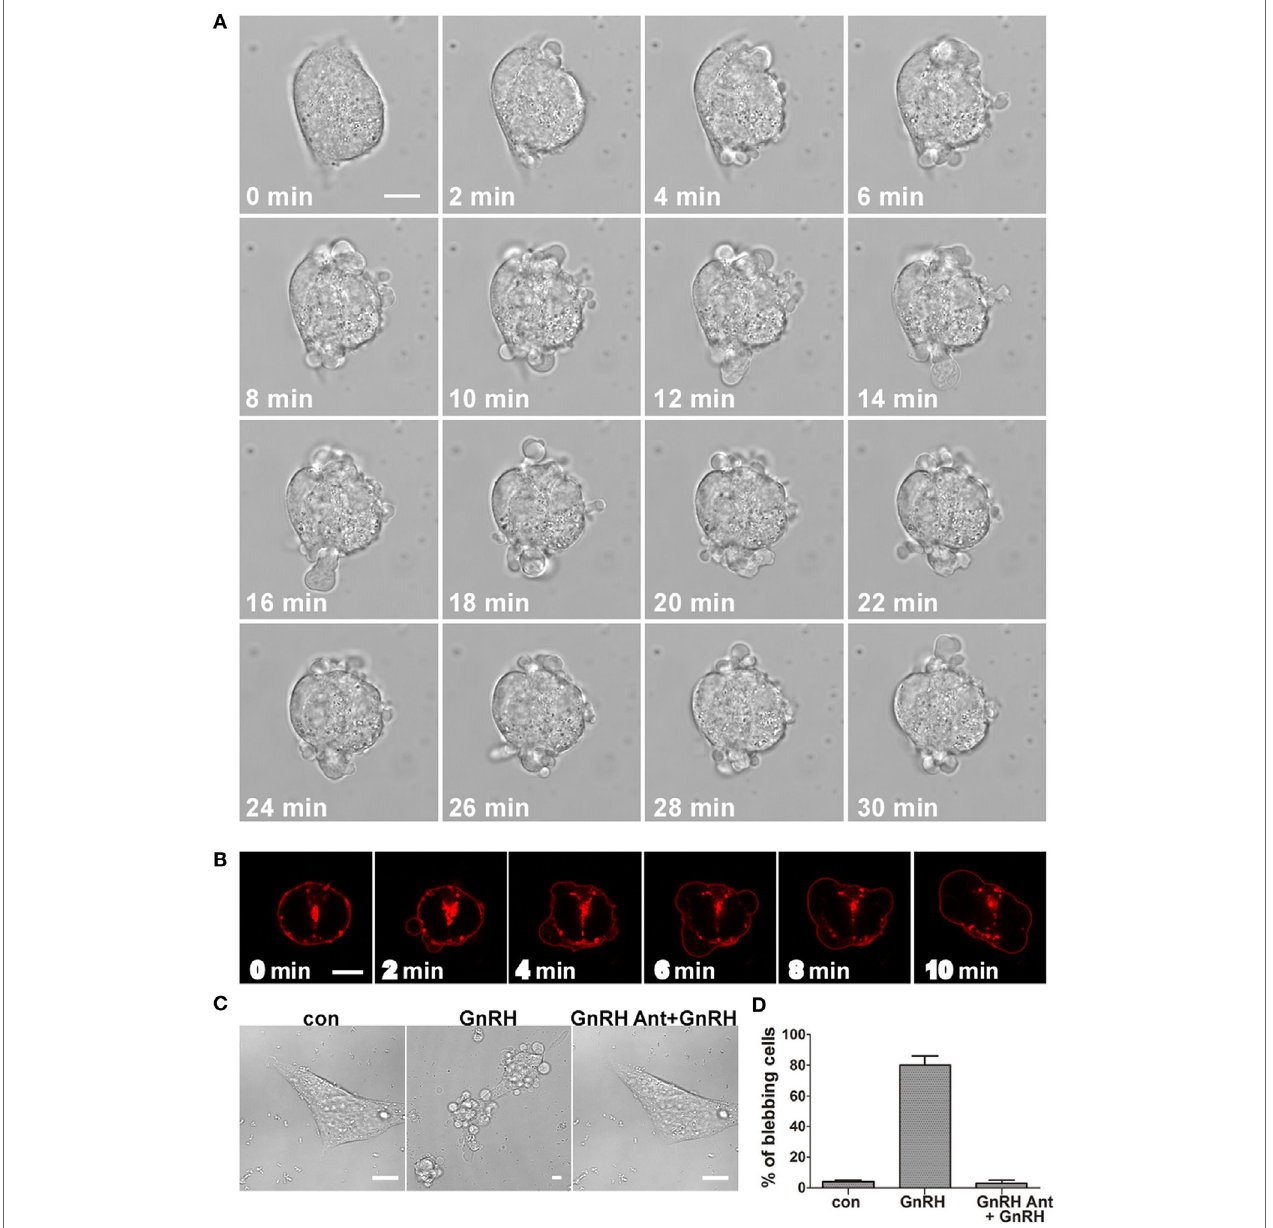
FigUre 1 | gnrh induces bleb formation in l β T2 cells and gnrh receptor (gnrhr) is present in the blebs . (a) Images from a confocal microscopy time-lapse movie of serum-starved L β T2 gonadotrope cells treated with GnRH (10 nM) (0–30 min). The treatment resulted in bleb formation. The scale bar is 10 µm. (B) GnRHR is present in the blebs. Serum-starved L β T2 cells were subjected to time laps confocal microscopy. Addition of GnRH (10 nM) (0–10 min) to L β T2 cells transfected with GnRHR-mCherry resulted in bleb formation, while GnRHR is present in the blebs. The scale bar is 5 µm. (c) GnRHR mediates the formation of the blebs by GnRH. Serum-starved L β T2 cells were incubated with GnRH (10 nM) (30 min), or preincubated first with 100 nM GnRH antagonist (cetrorelix acetate) for 30 min followed by GnRH (10 nM) (GnRH antagonist + GnRH) for additional 30 min. Cells were imaged using confocal microscope and the scale bar is 10 µm. (D) Quantitation of blebbing cells in control, GnRH and GnRH antagonist + GnRH. Images of at least 10 fields were taken for each treatment, and the bars are mean ± SEM from 3